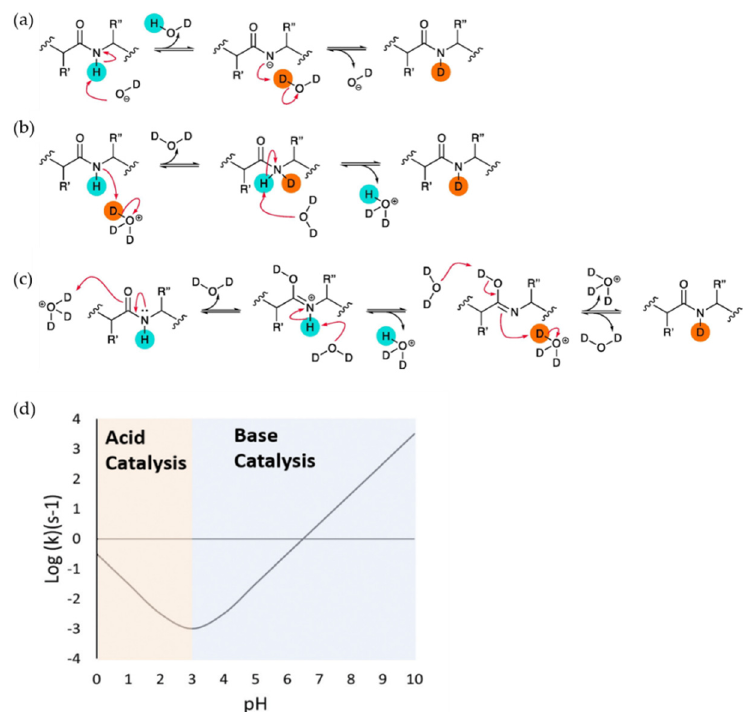
Figure 1. Schematic of acid and base catalysis of peptide group protons in solution during H-D exchange and the dependence of intrinsic rate of exchange (kch) on the pH of solution. ( a ) Base catalysis ( b ) Acid catalysis through the protonation of peptide group N atom. ( c ) Acid catalysis through protonation of peptide group O atom. Reproduced with permission from Journal Methods@ 2018. ( d ) The dependence of intrinsic rate of exchange (kch) of poly-DL-alanine on the pH showing that the minimum exchange is at pH 2.5–3. Acid catalysis is dominant below the pH and base catalysis is dominant above the pH. Reproduced with permission from the journal Analyst (© 2017) .